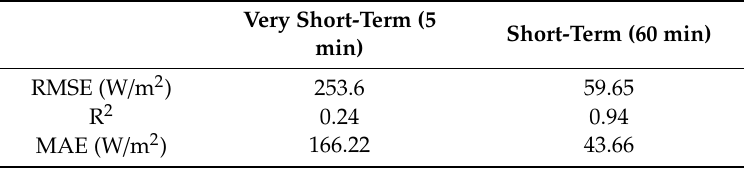
Table 7. Accuracy levels of the classical hybrid model